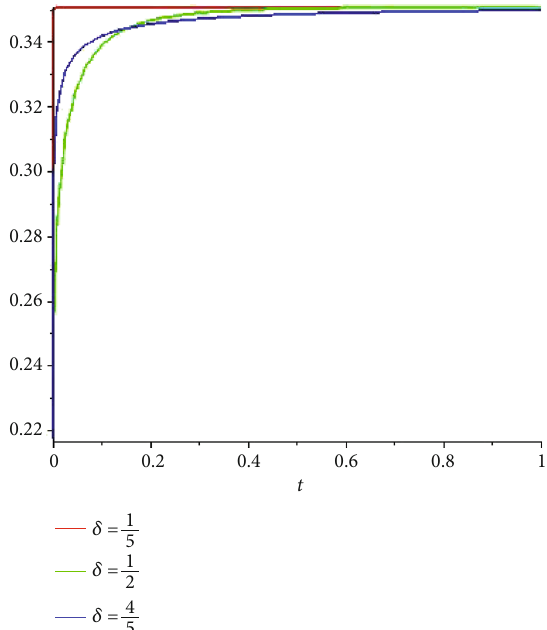
, x Þ at x = 1 : 0 in Equation (37) for di ff erential values of the fractional parameter Figure 6: The positive real part of u 1 1 ð t